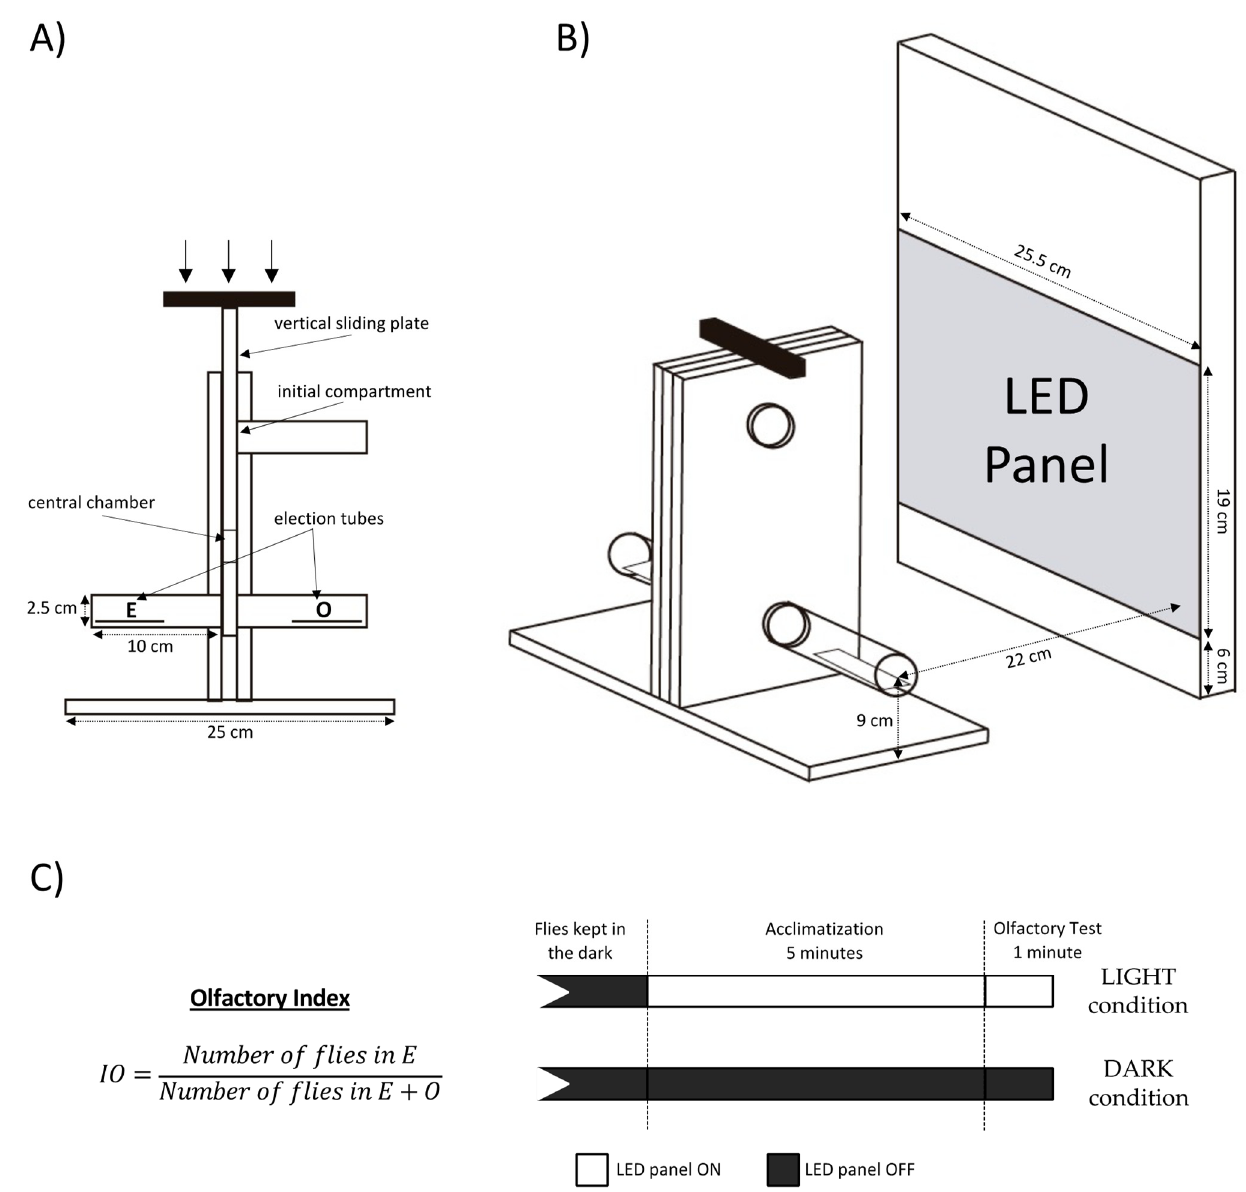
Figure 1. Dual-light odorant-excitation olfactory setup. ( A ) Schematic representation of the T-maze. ( B ) Relative positions of the T-maze and the LED panel for the optogenetic tests. ( C ) Olfactory Index formula (left) and illumination conditions used in the dose–response curve of ethyl acetate (right).